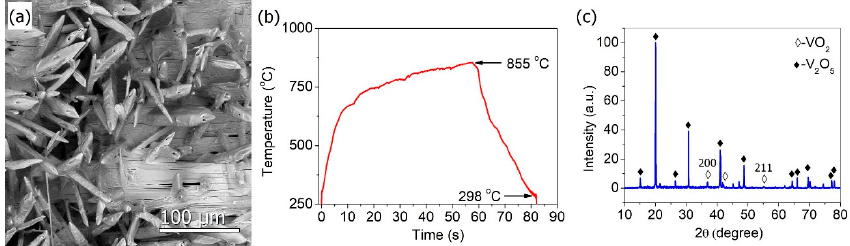
Figure 4. Characteristics of recrystallization product via heating with low peak temperature and cooling slowly: ( a ) SEM image, ( b ) temperature vs. time curve during recrystallization, and ( c ) XRD pattern.